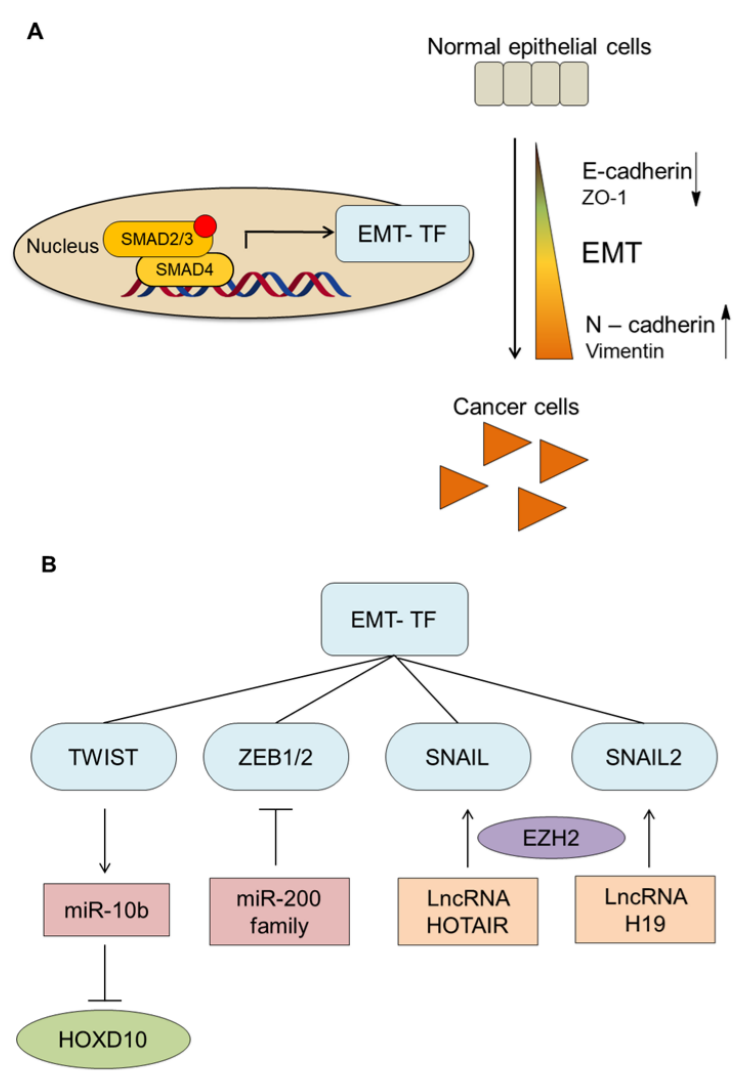
Figure 3. TGF- β signaling mediates EMT. ( A ) TGF- β is an important player in the activation of EMT, which is characterized by downregulation of epithelial markers and upregulation of mesenchymal markers. TGF- β via either SMAD or non-SMAD signaling can enhance the expression of EMT inducing transcription factors (EMT-TF) such as SNAIL1 / 2, ZEB1 / 2, and TWIST. ( B ) The involvement of miRNA and lncRNAs as important modulators of TGF- β signaling and EMT: miR-10b induces TGF- β -driven EMT by expression of HOXD10. MiR-200 family can negatively regulate ZEB1 / 2. LncRNA H19 upregulates EMT by interacting with SLUG or EZH2. LncRNA HOTAIR induces EMT by mediating the physical interaction between SNAIL and EZH2.